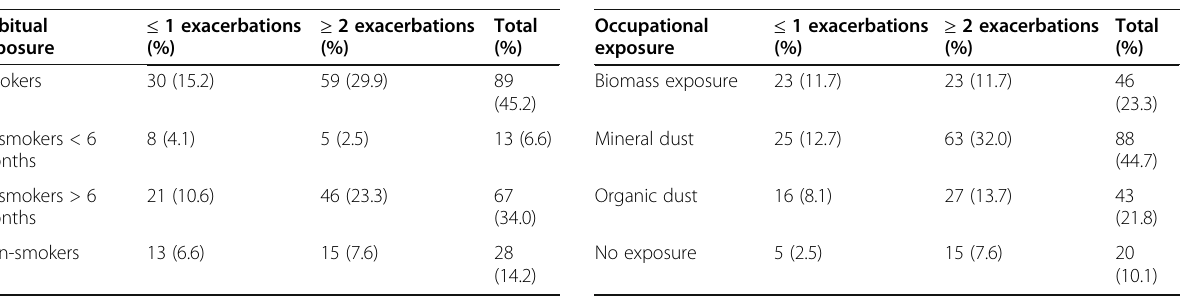
Table 7 Distribution of habitual exposure with number of exacerbations